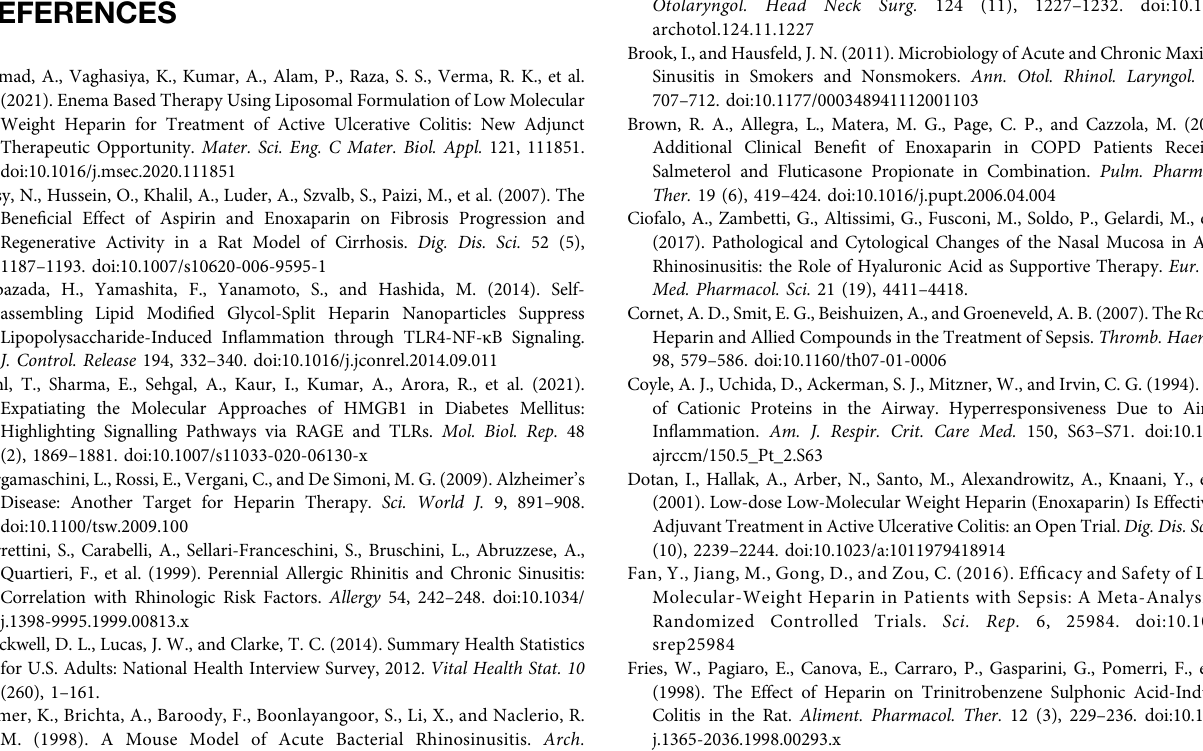
Supplementary Figure S1 | Overview of the experimental design. Supplementary Figure S2 | The relative western-blot quantization results of Figure 2 . Supplementary Figure S3 | The relative western-blot quantization results of Figure 3 . Supplementary Figure S4 | The relative western-blot quantization results of Figure 4